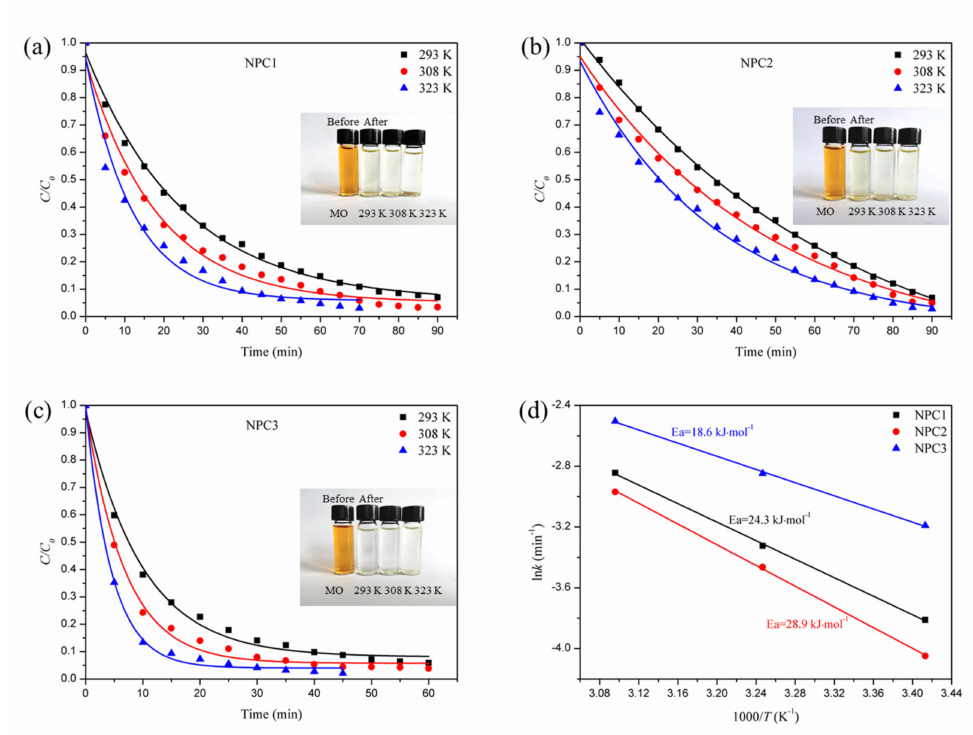
Figure 8. The normalized concentration ( C/C 0 ) with degradation time of nanoporous copper catalysts at three different temperatures, NPC1 ( a ), NPC2 ( b ), and NPC3 ( c ), and the Arrhenius plots of ln k versus 1/ T for the degradation toward MO by three different nanoporous copper catalysts ( d